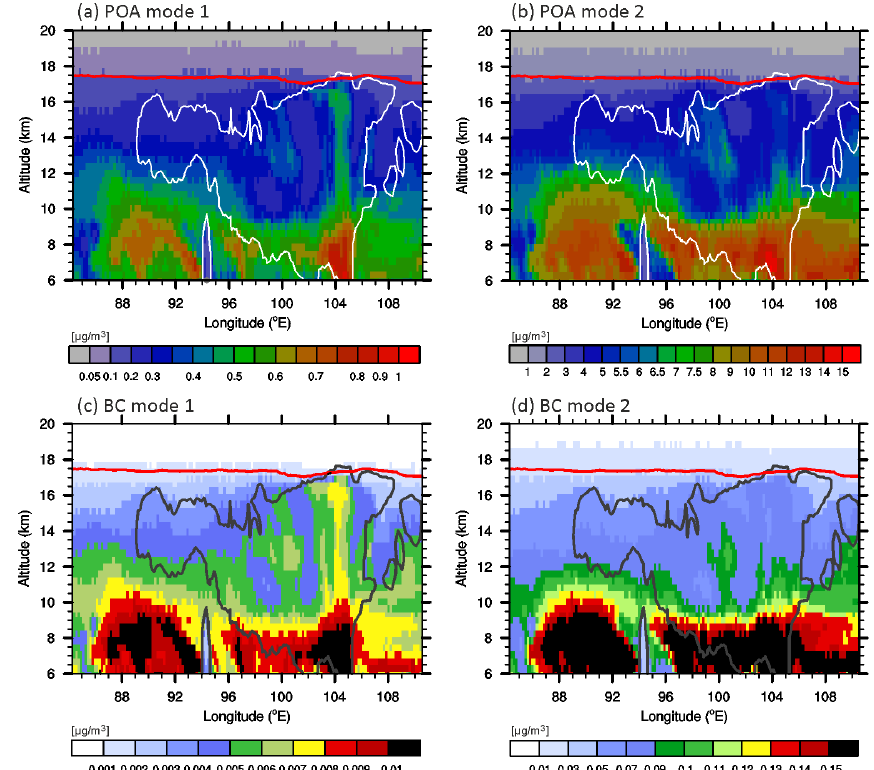
Figure 11. Vertical cross sections of (a) POA of mode #1, (b) POA of mode #2, (c) BC of mode #1, and (d) BC of mode #2 from 6 to 20km altitude along the x axis of the area of interest at 18:00UTC on 7 August. The isentropic altitudes of 380K is depicted by the red lines. The cloud boundary (mixing ratio of ice content of 10mgkg − 1 ) is contoured by the black or white line (for